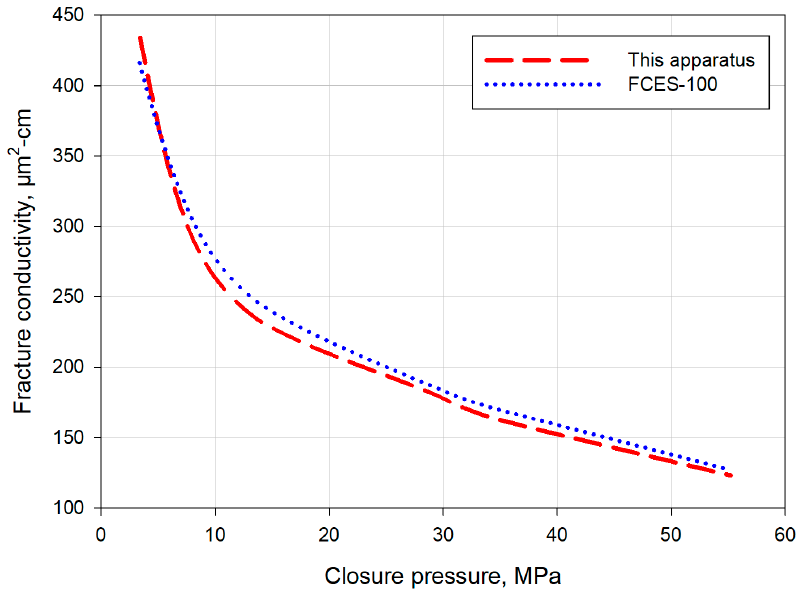
Figure 7. Comparison between conductivity data collected by this apparatus and FCES-100 under identical conditions. identical